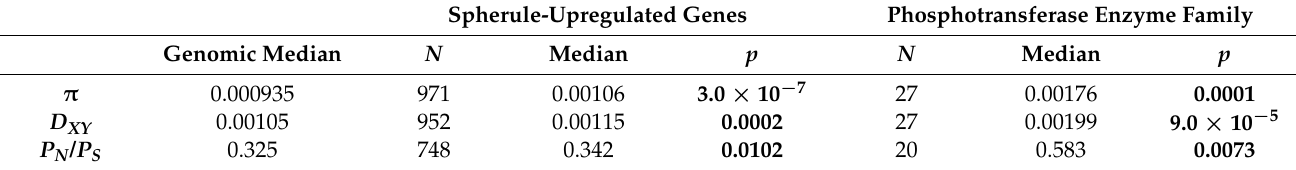
Table 2. Genes induced in spherules evolve quickly. Each row reports results from one population- genomic metric of single-nucleotide variation, as analyzed in genes across C. posadasii strains: π , average number of nucleotide differences between strain pairs in the Arizona population; D XY , absolute divergence between the Arizona and Texas/Mexico/South America populations; P N /P S , count of non-synonymous variants across the Arizona population relative to that of synony- mous variants. The first column reports the median of the indicated metric across all genes. The second, third, and fourth columns report, respectively, the number of genes induced in spherules with sufficient sequence data to calculate each metric, the median of the metric across genes in this gene set, and the results of a resampling-based test for enrichment of high values of the metric in this gene set; the last three columns report the analogous quantities for genes annotated with the phosphotransferase enzyme family. Bold values signify p <